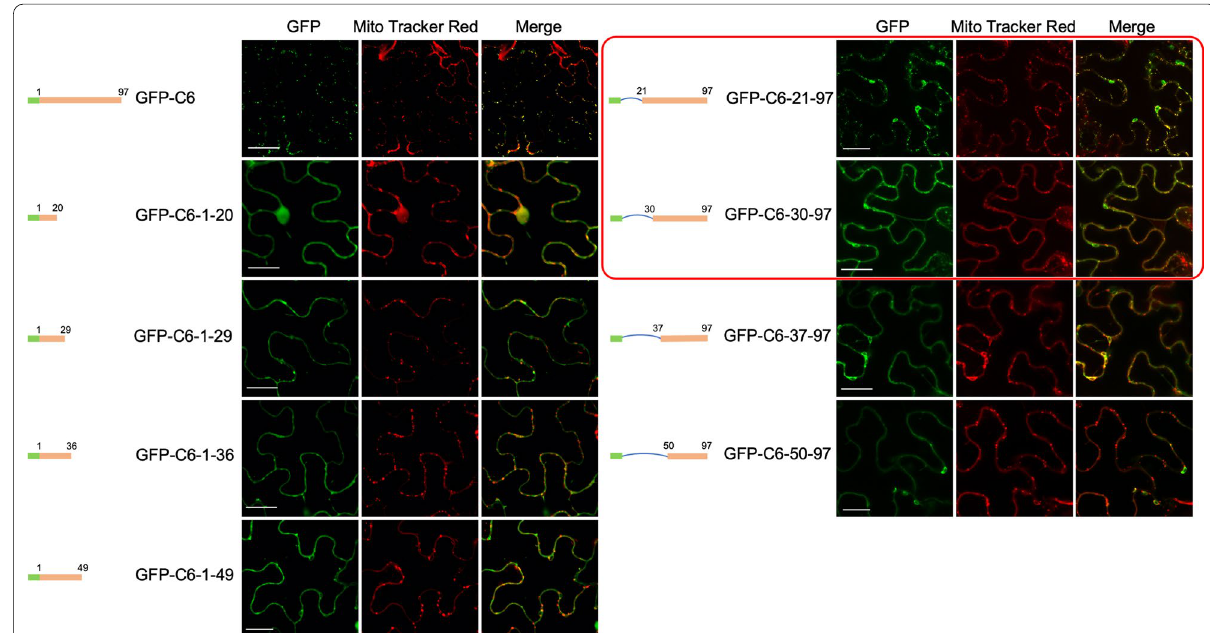
Fig. 4 Subcellular localization patterns of C6‑deletion derivatives. Amino acid residues of C6 retained in mutants are indicated. Columns from left to right represent GFP fluorescence, Mito Tracker Red fluorescence and overlay. Scale bars: 25 μm. Rectangle indicates C6 truncations with mitochondrial